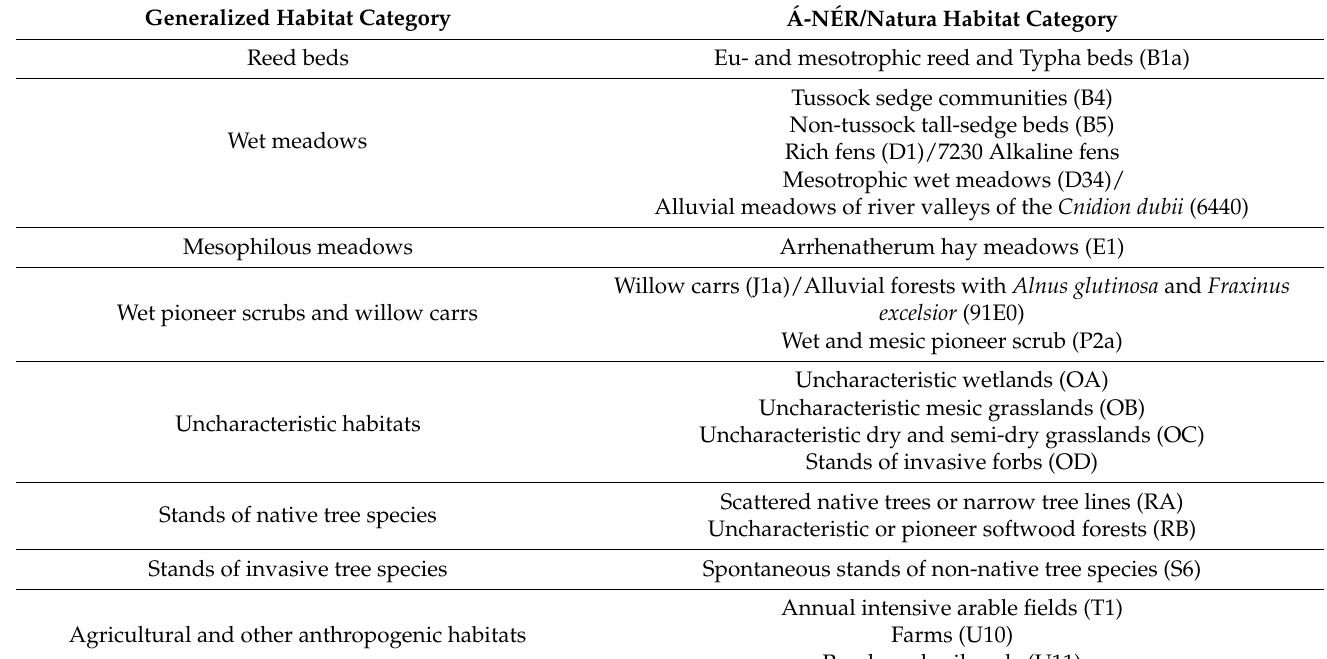
Table 2. Habitat categories of Á -N É R occurring in the area and our categorization of them. Generalized Habitat